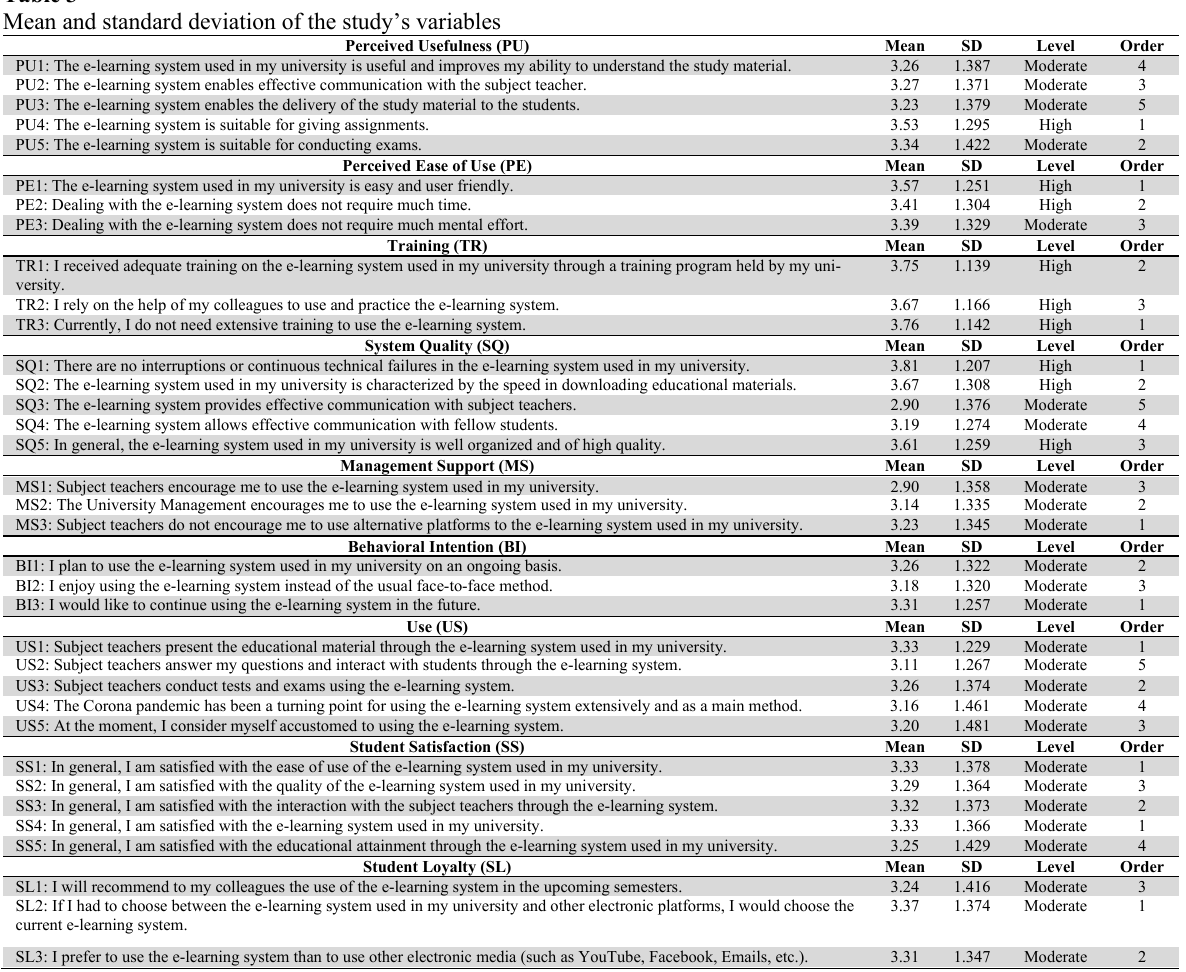
SS1: In general, I am satisfied with the ease of use of the e-learning system used in my university. 3.33